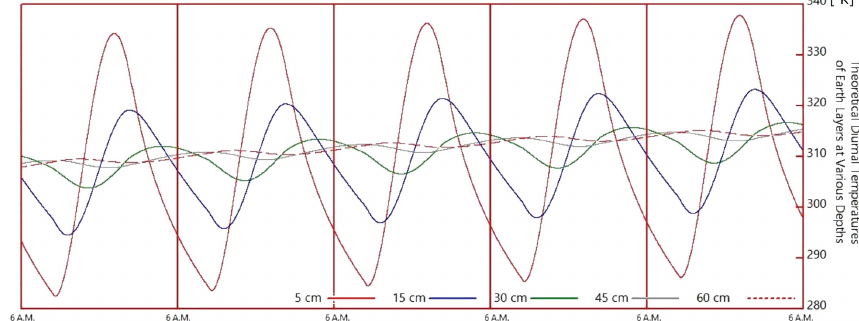
Fig. 2. Diurnal temperature changes at various depths of 5, 15, 30, 45 and 60 cm. Earth conductivity = 1. Phases of the so-called temperature-waves similar to those shown in the diagram of experimental measurements